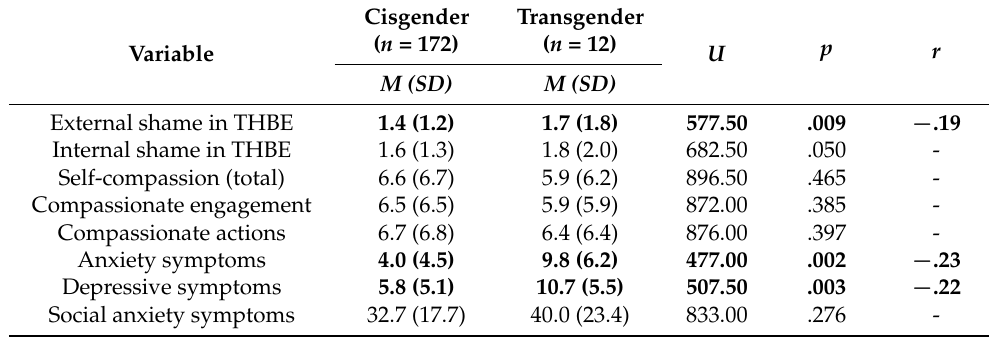
Table A2. Mean comparison considering gender identity in study